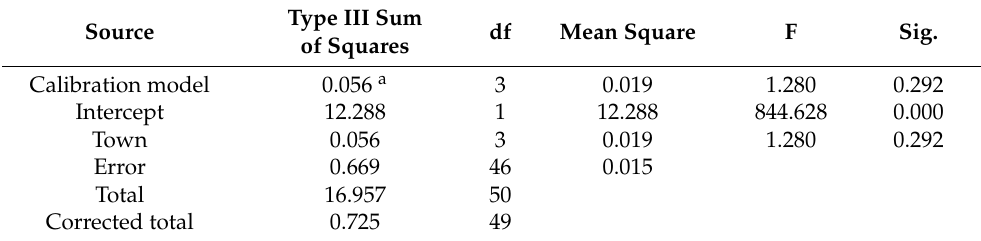
Table 10. One-way analysis of variance results table for preschools.